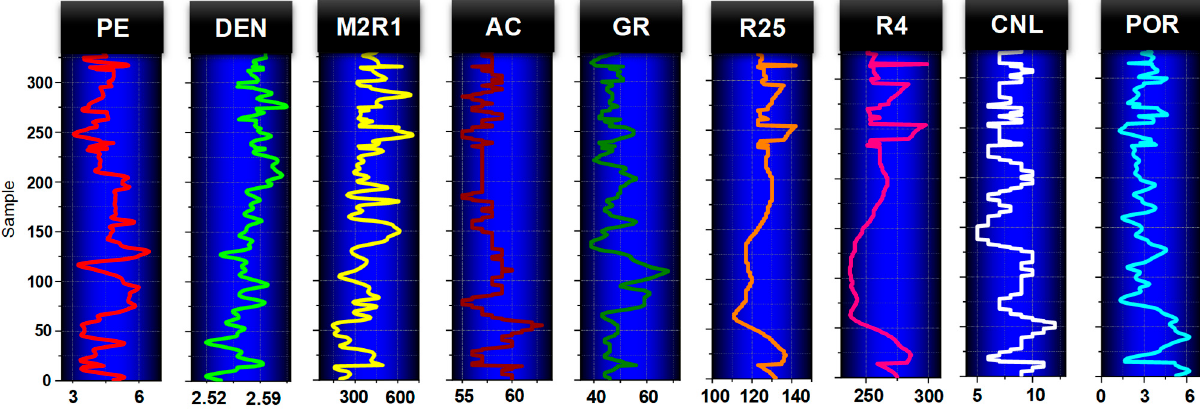
Figure 3. Logging parameters and porosity logging curve. Table 2. Data statistics and